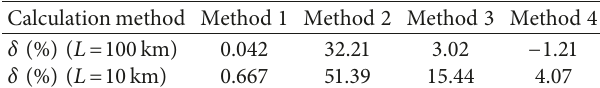
Table 2: Influence of the different methods of derivative calculation and different distances to the fault on the first-moment fault lo- cation error.